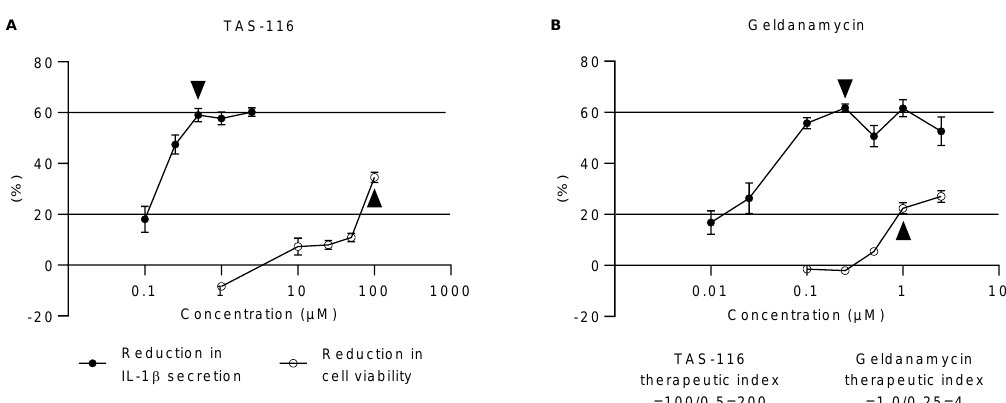
Figure 3. Therapeutic indices of TAS-116 ( A ) and geldanamycin ( B ). The therapeutic index is the ratio between toxic and therapeutic concentrations of a compound. When compared to primed RPE cells upon exposure to MG-132 and BafA, 0.5 µM TAS-116 and 0.25 µM geldanamycin concentrations, respectively, were sufficient to reduce the secretion of IL-1β by 60%. A TAS-116 concentration of 100 µM and a geldanamycin concentration of 1 µM reduced cell viability by over 20% when compared to untreated cells, as determined by the MTT assay. Arrowheads indicate the therapeutic ( (cid:72) ) and toxic concentrations ( (cid:78) ) of the compounds according to our predetermined cut-off points. Data are combined from two to three independent experiments with four parallel samples in each group and are presented as mean ± SEM.